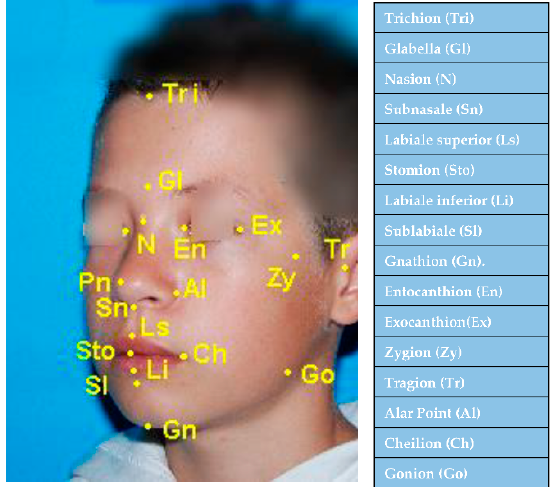
Figure 2. The median and lateral anthropometric points recommended for the anthropometric simplified technique. simplified technique.